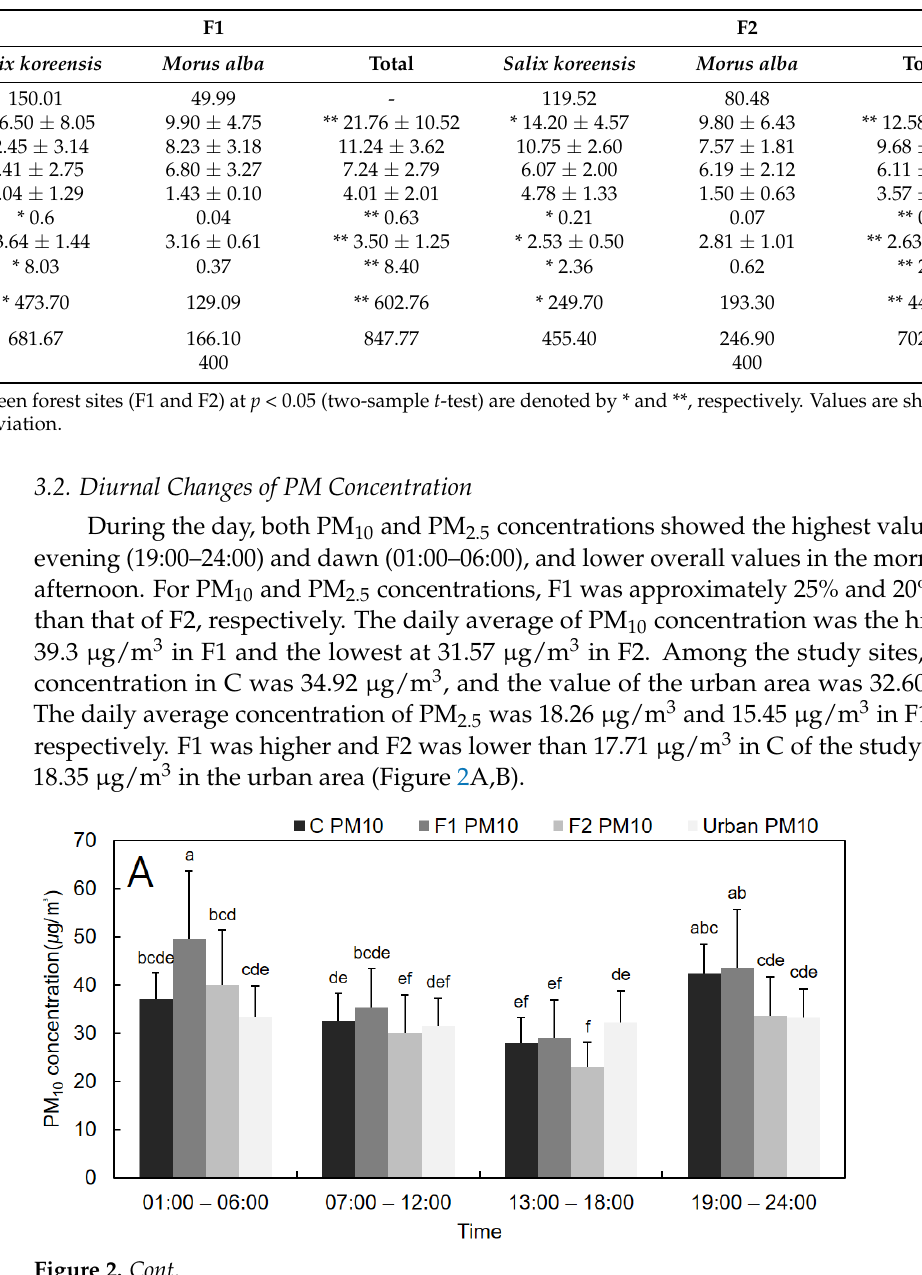
Figure 2. Diurnal changes in PM concentration (µg/m 3 ) in the Yeouido Saetgang Ecological Park. ( A ) Hourly PM 10 concen- tration at the measuring points. ( B ) Hourly PM 2.5 concentration at the measuring points. The same letter indicates no sig- nificant difference between measurements ( p < 0.05, one-way analysis, ANOVA, and then Tukey’s test for multiple com- parisons). Values are shown as means ± standard deviation. C; control, F1 and F2; urban forest site 1 and 2, respectively, Urban; Urban area. 3.3. Seasonal Changes in the PM Concentration The PM 10 concentration before leaf development was approximately 22% higher than those after the leaf development in both C and urban areas. However, the PM 10 concen- trations were 68% and 65% higher in F1 and F2, respectively. Urban forest area had a larger difference in seasonal PM 10 concentrations than urban areas (Figure 3A). In the case of PM 2.5 , the concentrations after leaf development were approximately 4%–5% higher than those before leaf development in the C area and urban areas, whereas they were approximately 28% and 55% lower in F1 and F2, respectively (Figure 3B). To investigate the relationship between wind and PM, we analyzed the seasonal changes in pollution roses using measured data from the monitoring stations. We exam- ined the pollution roses and analyzed the effects of weather patterns on contamination formation. In the C area and urban areas, which had similar heights, the wind speed was faster, and the wind direction was different to that in F1 and F2, which were located in the lower areas (Table 2). Therefore, the ratios of PM 10 and PM 2.5 concentrations were also